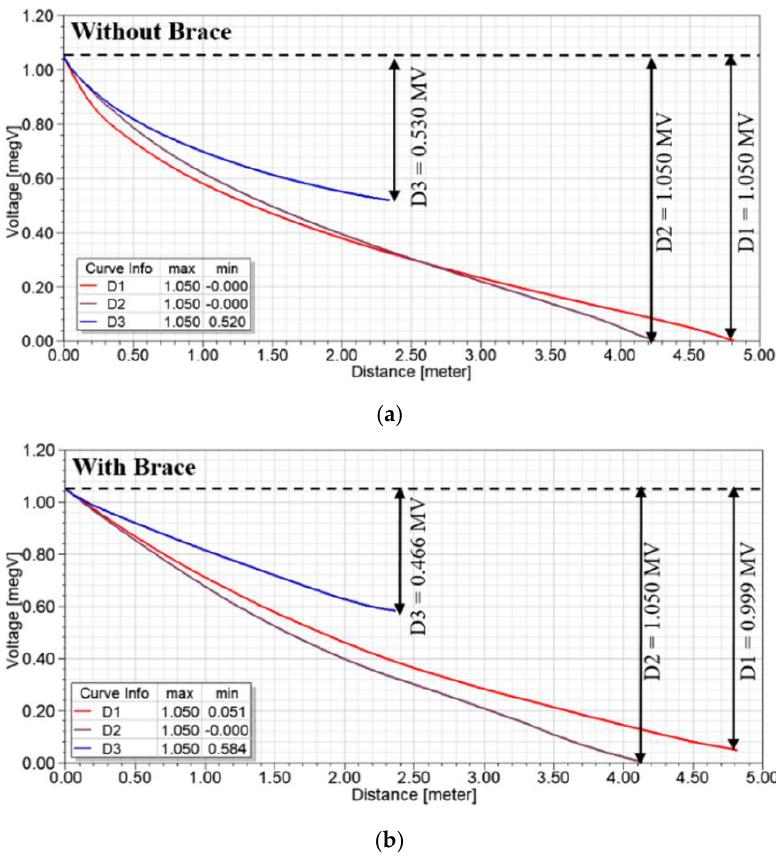
Figure 9. Potential distribution and the average potential along D1, D2, and D3 for the case ( a ) without a brace and ( b ) with a brace.